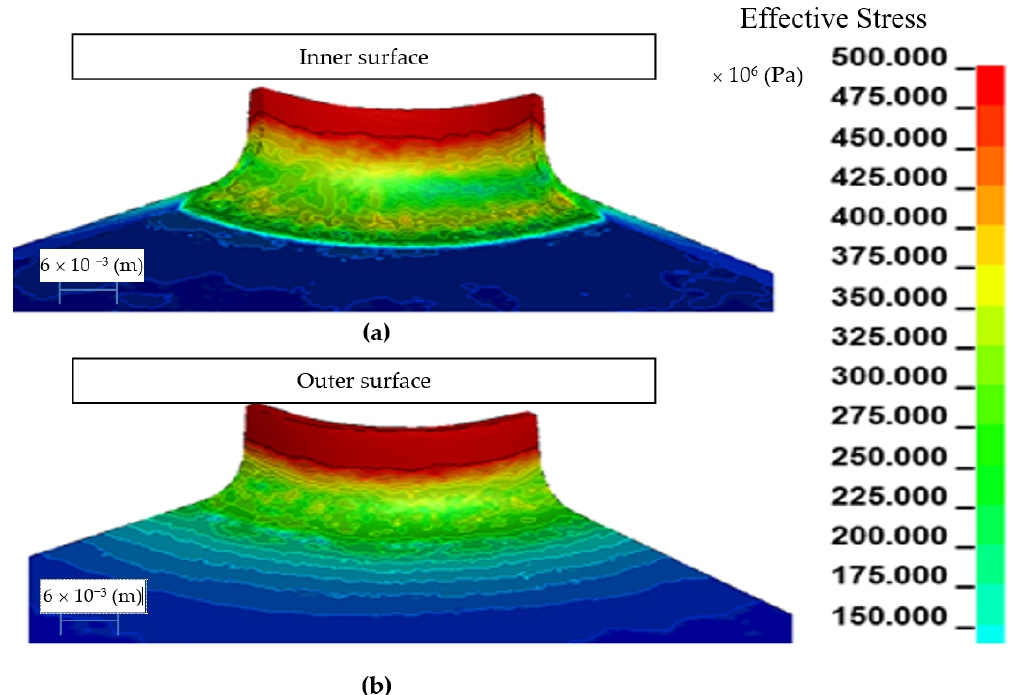
Figure 10. Effective stress in the embossed flange with a punch for the h10 model: view of the inside side ( a ), view of the outside side ( b ).